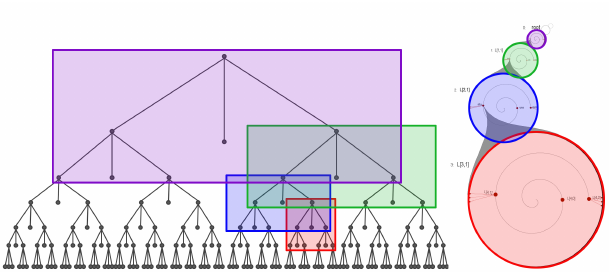
Figure 10. A tree with 190 nodes and 7 levels in both node-link and PaisleyTree layout. In PaisleyTrees, each node circle shows three levels: a node and all of its children and